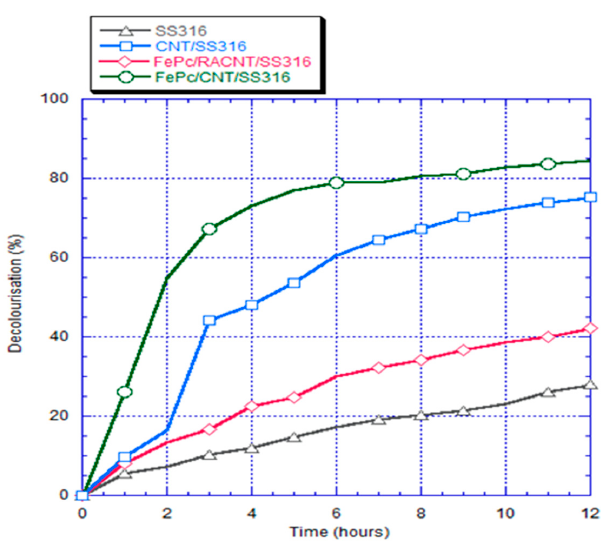
Figure 12. Plot showing rates of decolorization for different electrode systems (concentration of RB5: 50 ppm).